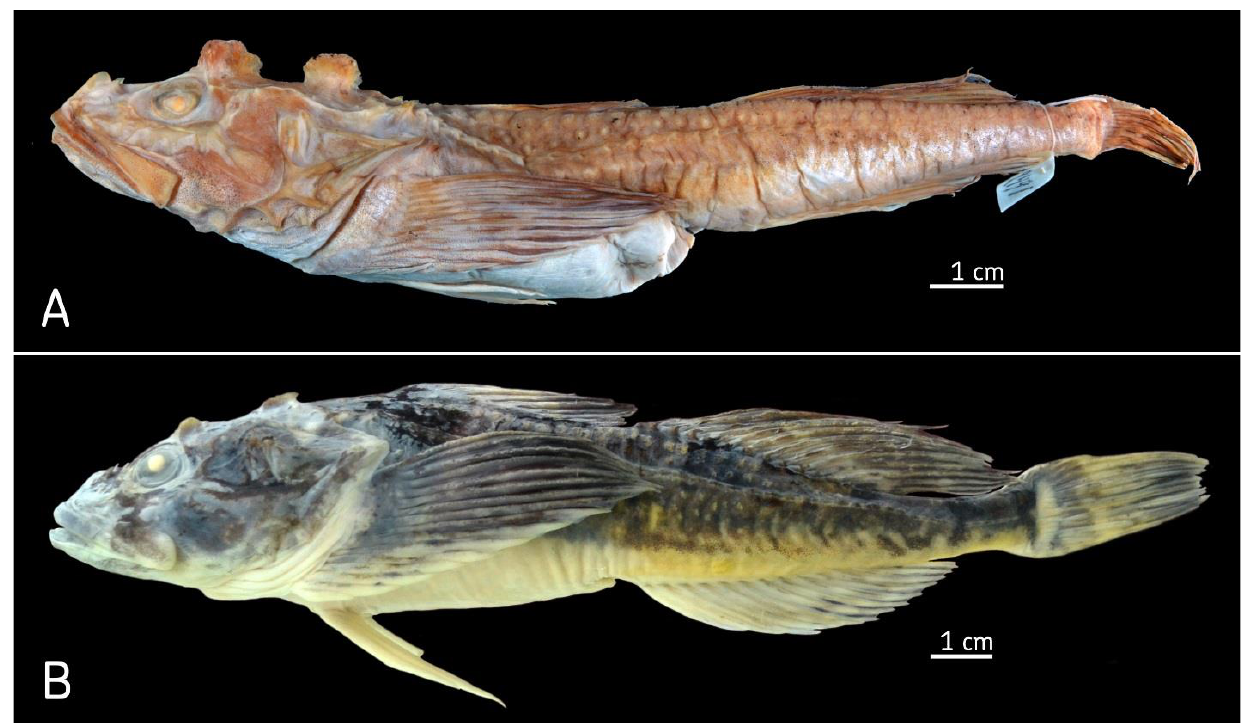
Figure 2. The photographs of fourhorn sculpins: ( А ) T. quadricornis , female, NRM 2491, syntype, Baltic Sea; ( B ) Triglopsis sp., female, ZIN 56884, White Sea, Chupa Bay near Sredniy Island, August 2020.